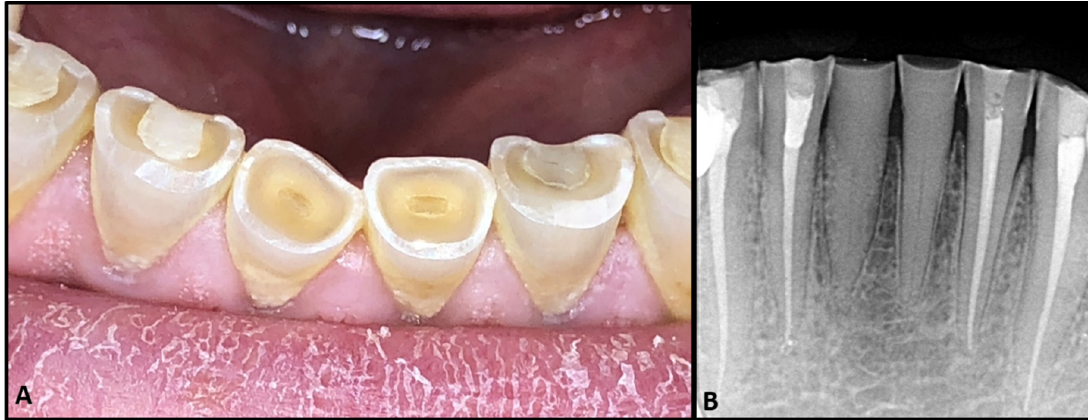
Figure 1. (A) Image showing severe tissue loss due to severe bruxism. (B) Initial pre-op